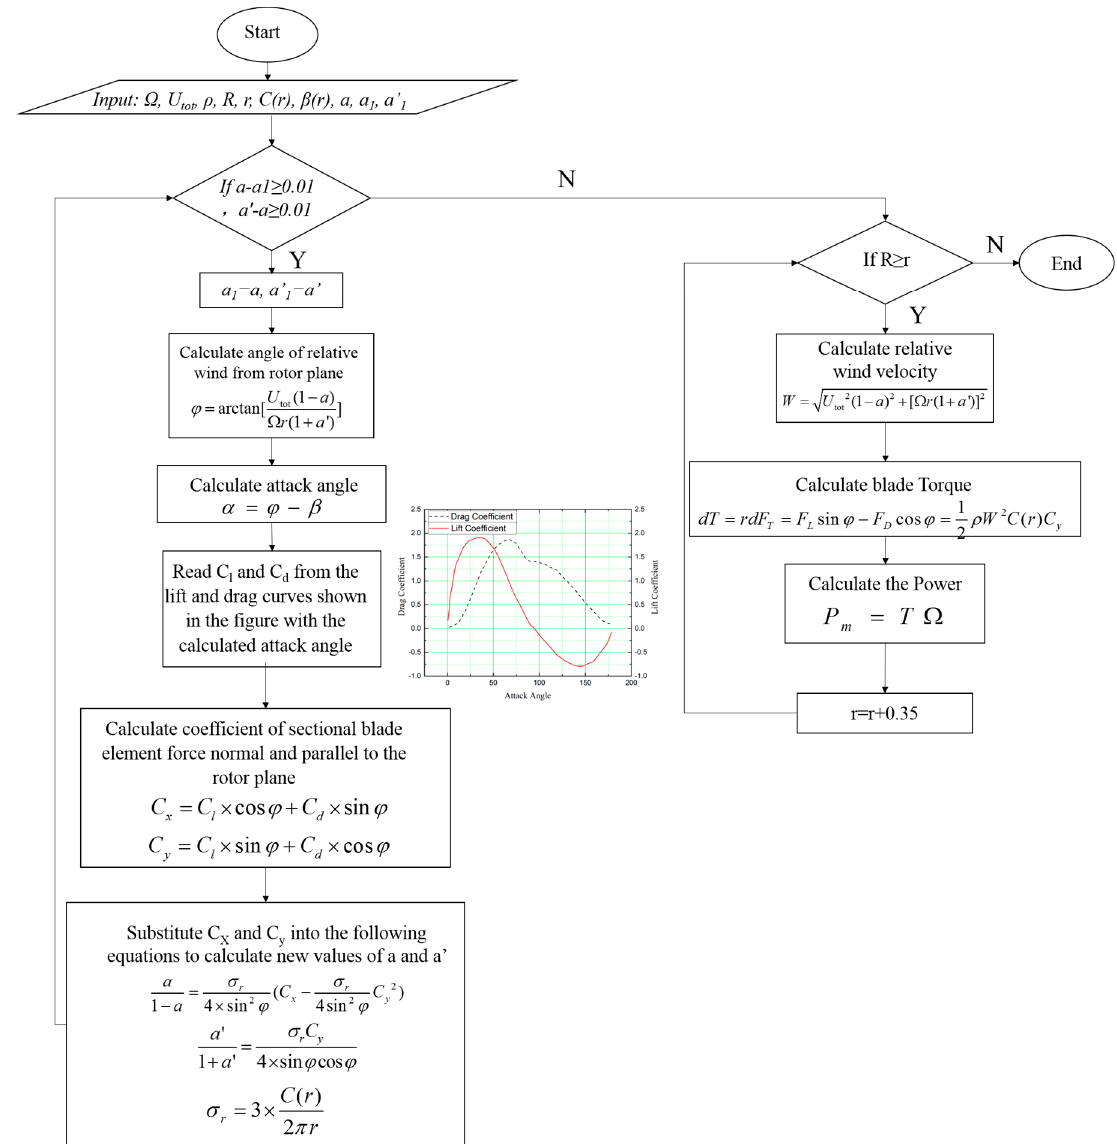
Figure A2. Flowchart for calculating blade production power using BEM theory.